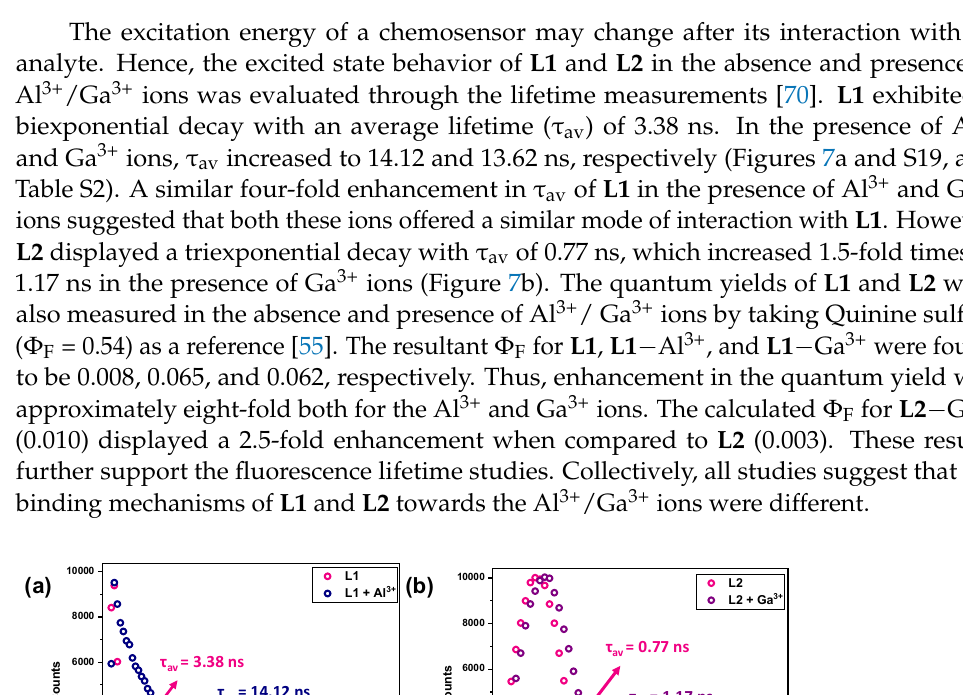
Figure 6. Selectivity of chemosensor L1 towards the Al 3+ ion in the presence of other metal ions: L1 + metal ions (yellow cones) and L1 + metal ions + Al 3+ ion (purple cones). All studies were conducted in EtOH.